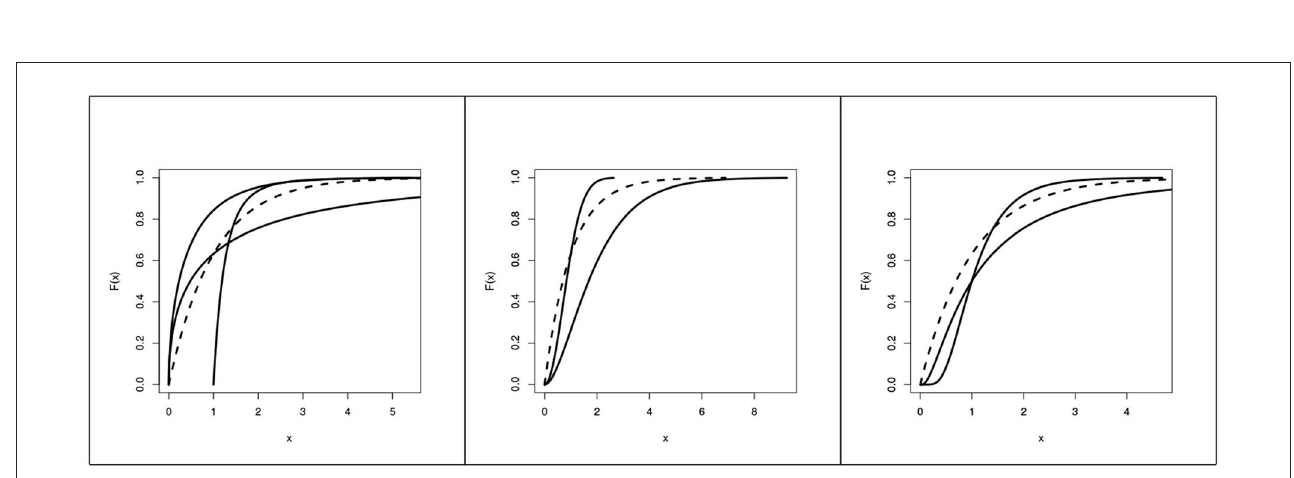
FIGURE2 CDF of the alternative groups G 1 , G 2 , and G 3 (left to right) and the CDF of a standard exponential distribution